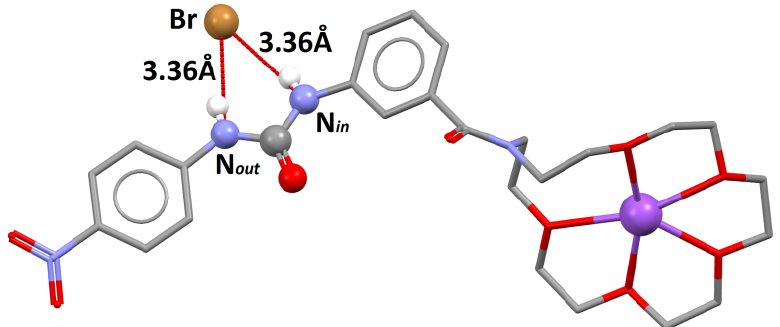
Figure 6. The crystal structure of 2 · NaBr: Urea and carbonyl groups are presented as balls; solvent molecules, most of the hydrogen atoms, and disorder were omitted for clarity; selected hydrogen bonds are presented as red lines connecting corresponding donor and acceptor groups.